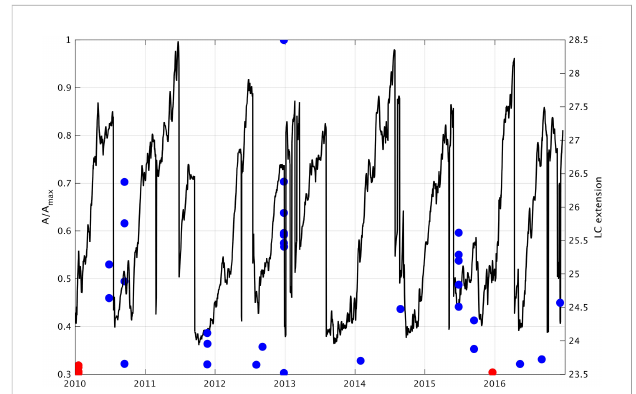
FIGURE 2 Left y-axis: Normalized area of largest coherent boundaries (diameter>=90 km), detected in the northwestern Caribbean Sea and crossed the Yucatan Channel from 2010 to 2016. The blue and red dots represent coherent anticyclonic and cyclonic boundaries, respectively. Right y-axis: LC northernmost extension (black line), based on the position of the 17-cm SSH anomaly contour from 2010 to 2016. The dots ’ projection onto the x-axis corresponds to the dates that the boundaries are identi fi ed as coherent in the northwestern Caribbean Sea and mark the fi rst day of